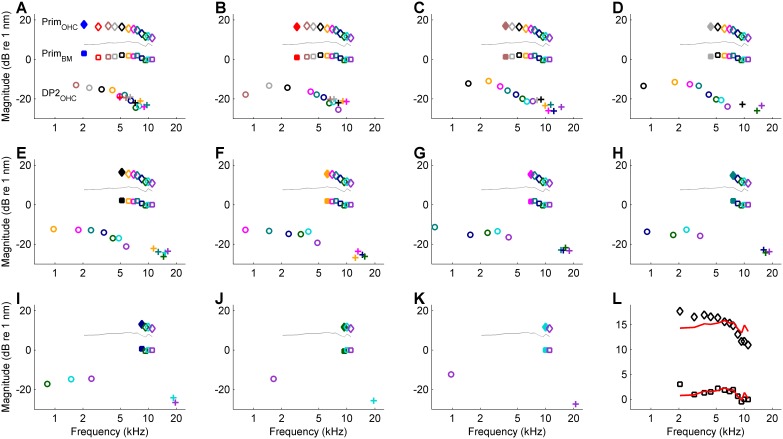
Comparison of linear response components and second-order distortion products (DP2s).Data from recording shown in the lowest curves in Figure 4A–C (CF = 25 kHz; estimated cutoff frequency, 3006 Hz). (A–K) The DP2s are split according to their ‘heritage’ and the linear response components (‘parents’) are also shown. In A all the DP components relating to the lowest primary are shown. In B, that lowest primary is excluded and all the DP components relating to the new lowest primary are shown, and so on through panel K. Diamonds, linear response component (primary response) measured in the hotspot (OHC/Deiters’ region). Squares, primary response measured on the basilar membrane (BM). Circles, difference tones at f2- f1 measured in the hotspot. Plus signs, sum tones at f1+ f2 measured in the hotspot. The solid lines in all panels are identical; they show the effective OHC input determined from the DP2 spectrum. Their overall magnitude is unknown; the vertical position of the curves is chosen halfway the linear responses of BM and hotspot to facilitate comparison. The DP2s are split according to the lower primary f1. The filled symbol in each panel marks the f1 of all the DP2 components in that panel. The colors of the DP2s at f1+ f2 (plus signs) and f2- f1 (circles) match the colors of the linear responses at f2 in the same panel. (L) Detailed comparison between effective OHC input and primary responses. The effective OHC input (red lines) is shown at two different vertical positions: shifted for maximum overlap with primary responses at the hotspot (diamonds) and the BM (squares). The overlap is better for the BM data (RMS deviation, 0.9 dB) than for the hotspot data (RMS deviation, 1.9 dB).